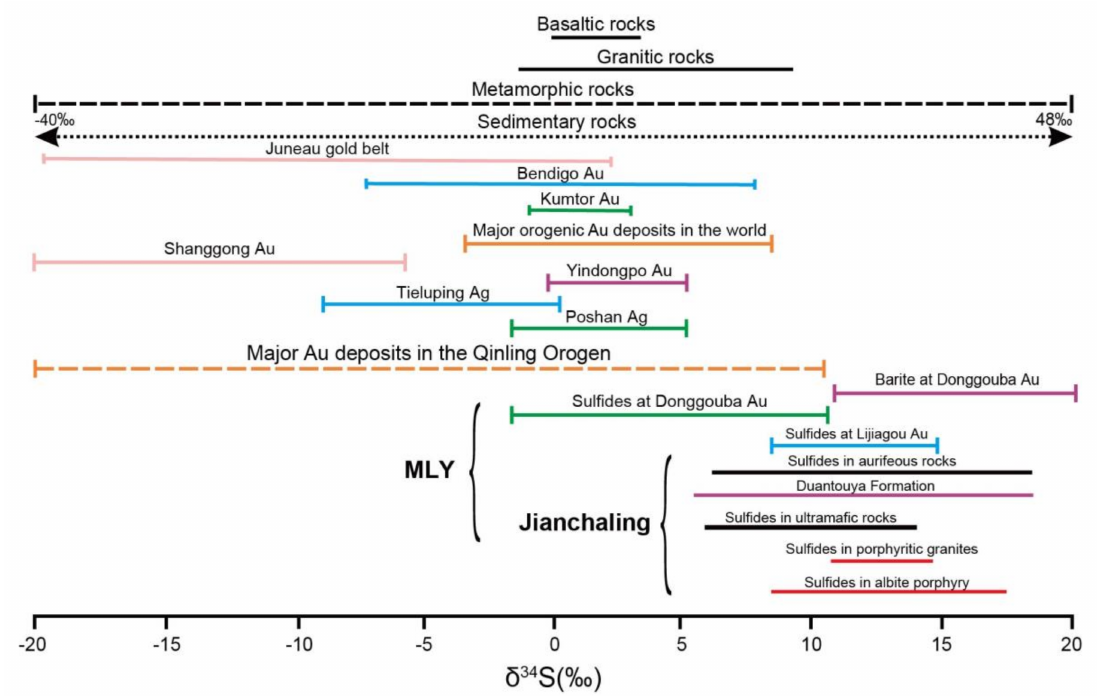
Figure 8. δ 34 S values for hydrothermal sulfides from the Jianchaling Au deposit. Data sources: Basaltic rocks, Granitic rocks, Metamorphic rocks and Sedimentary rocks after [62,72,80]; Juneau gold belt, Bendigo Au, Kumtor Au and Major orogenic Au deposits in the world after [12,81]; Shanggong Au and Tieluping Ag after [44]; Yindongpo Au after [66]; Poshan Ag after [82]; Major Au deposits in the Qinling Orogen